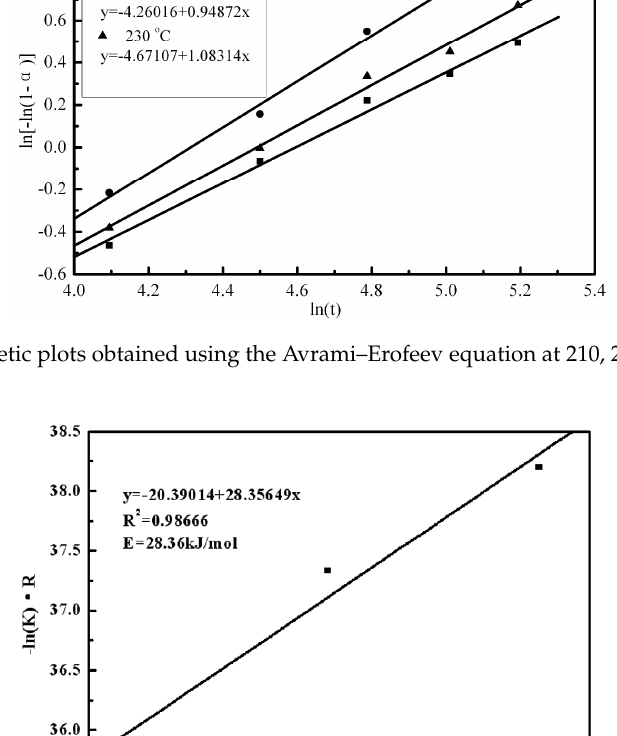
Figure 10. Kinetic plots obtained using the Avrami–Erofeev equation at 210, 220, and 230 °C. Table 3. Reaction kinetics calculated using data acquired at 210, 220, and 230 °C.